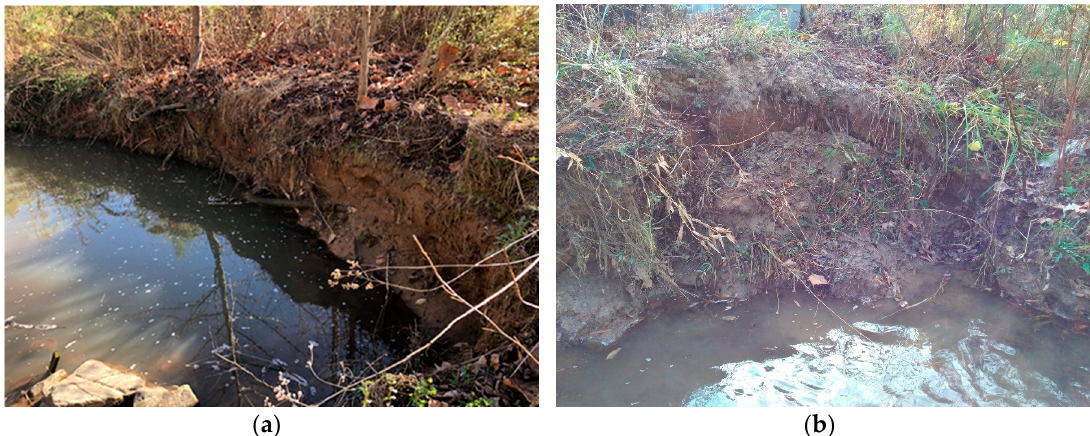
Figure 1. Post-restoration streambank ( a ) erosion and ( b ) failure in Richland Creek, Wake County, NC, USA. Pictures courtesy of the NCSU BAE-DMS stream restoration team.